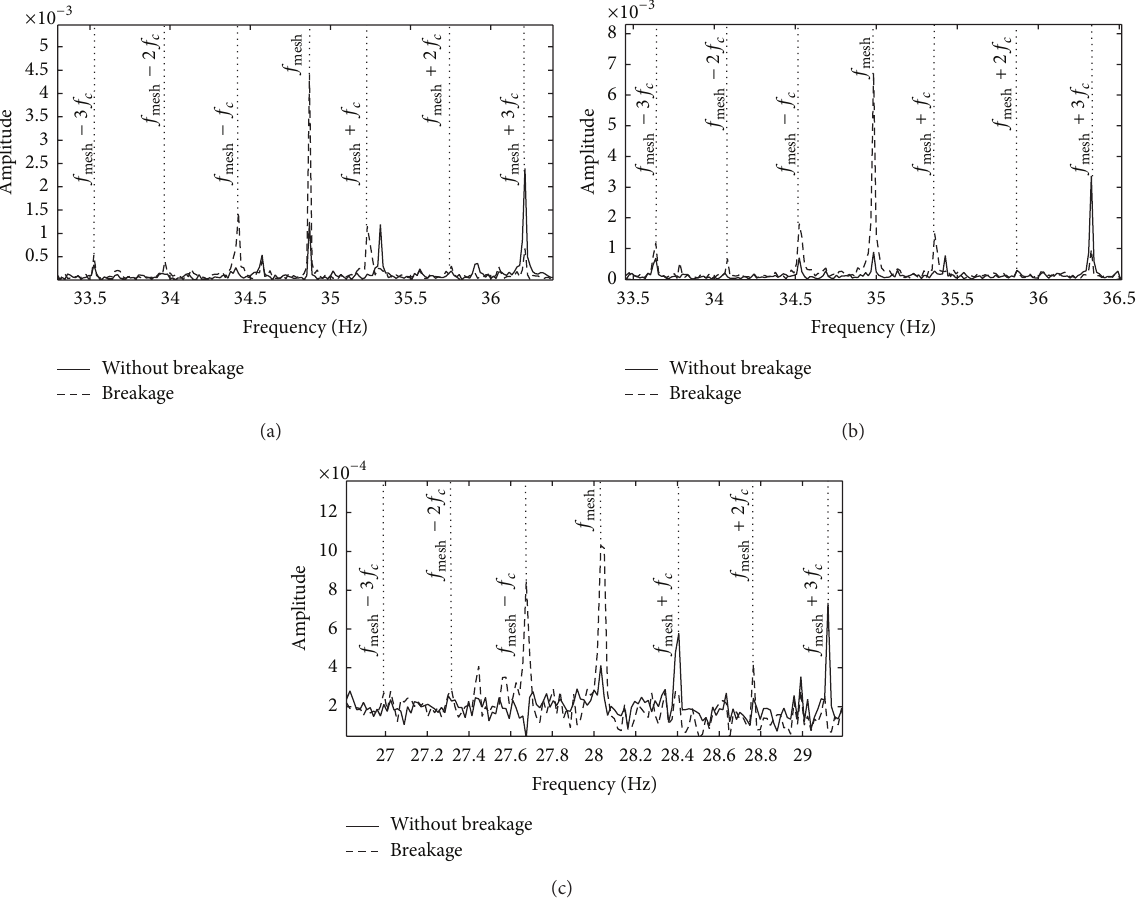
Figure 11: The spectrum of the system with and without tooth breakage on ring gear at different loads and speeds: (a) load = 200 N ⋅ m, input speed = 2.77 rad/s, (b) load = 229 N ⋅ m, input speed = 2.77 rad/s, and (c) load = 229 N ⋅ m, input speed = 2.24 rad/s.